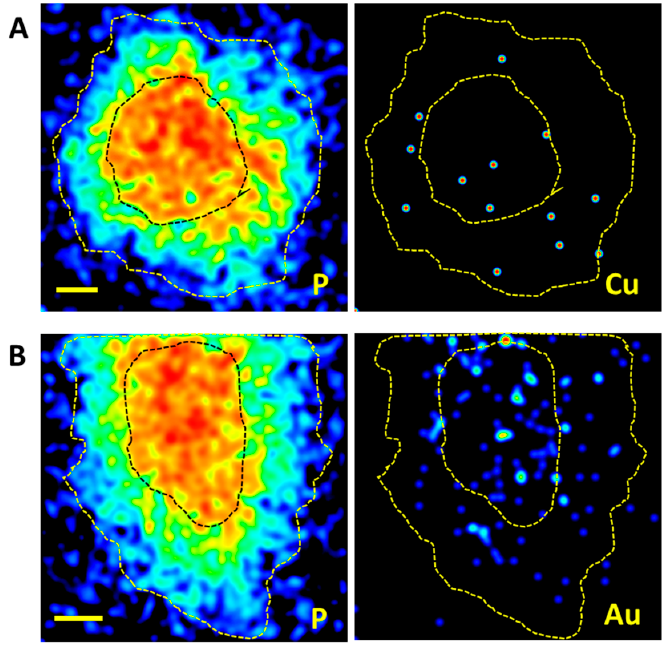
Figure 9. Nuclear microscopy images of OVCAR3 cells treated with complex 1 ( A ) and complex 9 ( B ). The cell morphology can be visualized in the map of phosphorus (P) distribution (cytoplasm (low content) and nucleus (high content)), to help interpreting the Cu and Au distributions. The gradient amount is represented by a dynamic color scale: low—blue to high—red. The dashed lines delineate the cell and nucleus contours. Scale bar: 5 μ m.